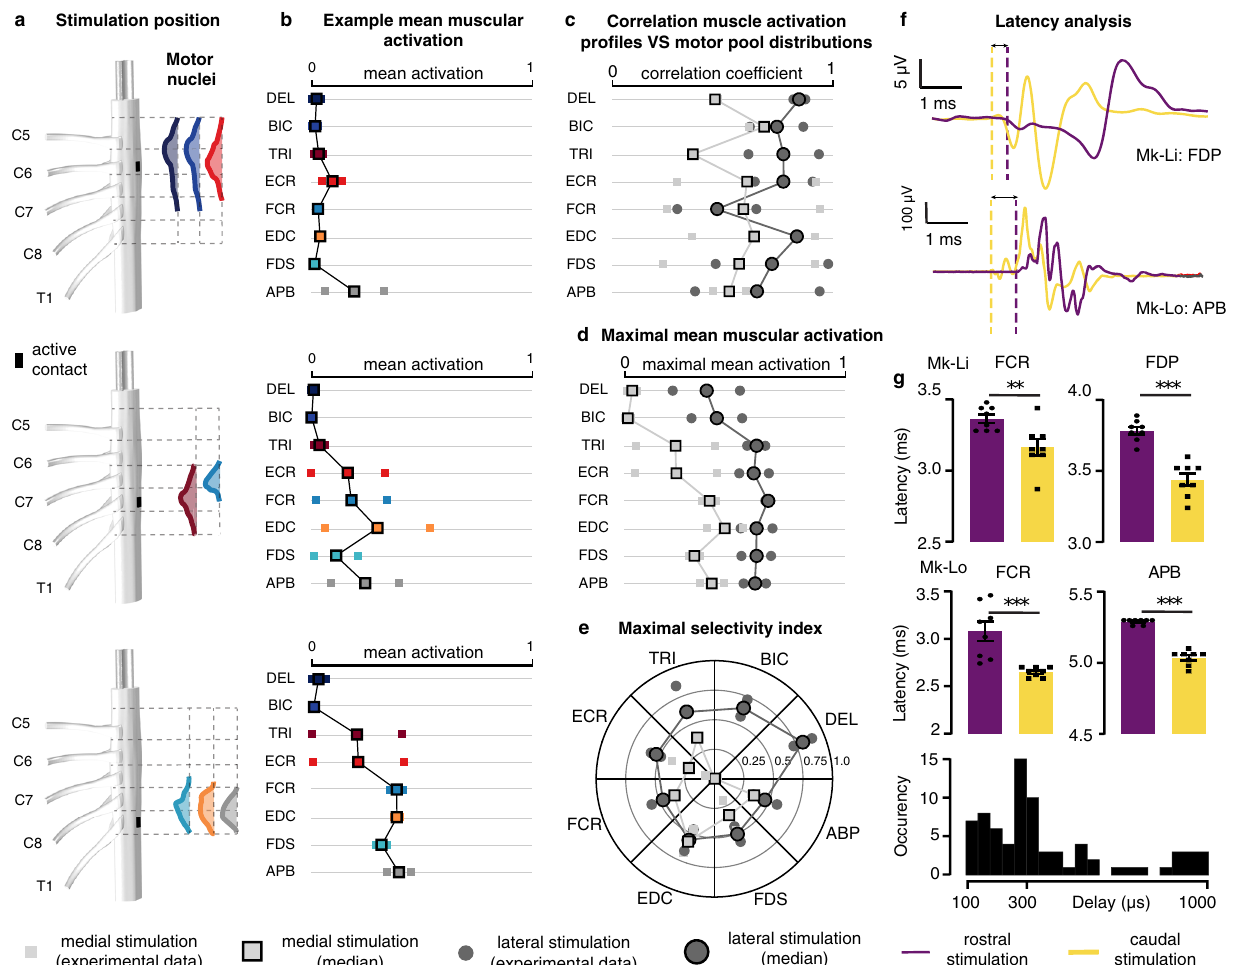
Fig. 5 Comparison of muscular recruitment pro fi les induced by lateral and medial electrodes. a Approximate positions of the medial electrodes used to obtain the results in ( b ) and underlying motoneuronal distributions. Electrode contacts are magni fi ed for better visualization (scale factor = 2). b Mean muscular activations obtained with the medial electrodes at the same rostro-caudal levels than the lateral electrodes of Fig. 4c for the 2 monkeys implanted with the design-1 array (see “ Methods ” ). DEL: deltoid, BIC: biceps brachii, TRI: triceps brachii, FCR: fl exor carpi radialis, FDS: fl exor digitorum super fi cialis, ECR: extensor carpi radialis, EDC: extensor digitorum communis, APB: abductor pollicis brevis. c Correlation coef fi cients between muscular recruitment pro fi les and motor nuclei distributions (see “ Methods ” ) for lateral and medial electrodes. d Maximal mean muscular activations achieved with lateral or with medial electrodes. e Maximal selectivity indexes (see “ Methods ” ) achieved with lateral or medial electrodes. In b – e data points (small squares/circles without borders) may be hidden by medians (large squares/circles with black borders). f Examples of muscular response latencies following stimulation from rostral medial or caudal medial electrodes. Top: muscular responses recorded in the fl exor digitorum profundis of monkey Mk-Li. Bottom: muscular responses recorded in the abductor policis brevis of monkey Mk-Lo. Onsets of responses are indicated by the vertical dashed lines. g Statistical analysis of the differences in onset latencies between rostrally-induced responses and caudally-induced responses (two-sided unpaired t -tests, ** p < 0.01; *** p < 0.001, see “ Methods ” ). For each muscle, eight responses induced at amplitudes near motor threshold with one rostral (purple) and one caudal (yellow) electrodes were retained. Bottom histogram: distribution of the delay of rostrally-induced responses compared to caudally-induced